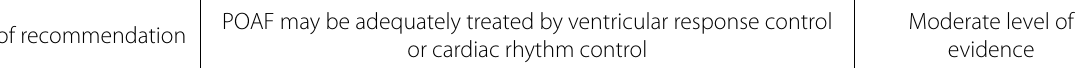
Table 2 . Prophylactic measures for postoperative atrial fibrillation (POAF) [10] . Strong class of